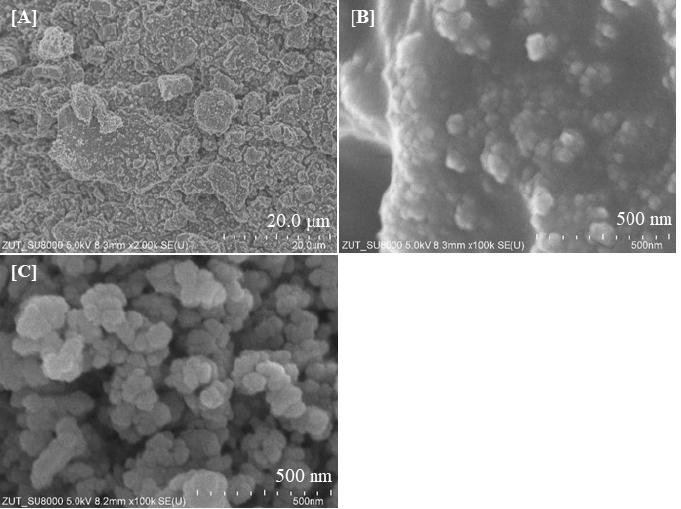
Figure 6. SEM microscopic images of ( A , B ) starting TiO 2 taken at different magnifications, ( C ) SiO 2 (11.1%)/TiO 2 _800.